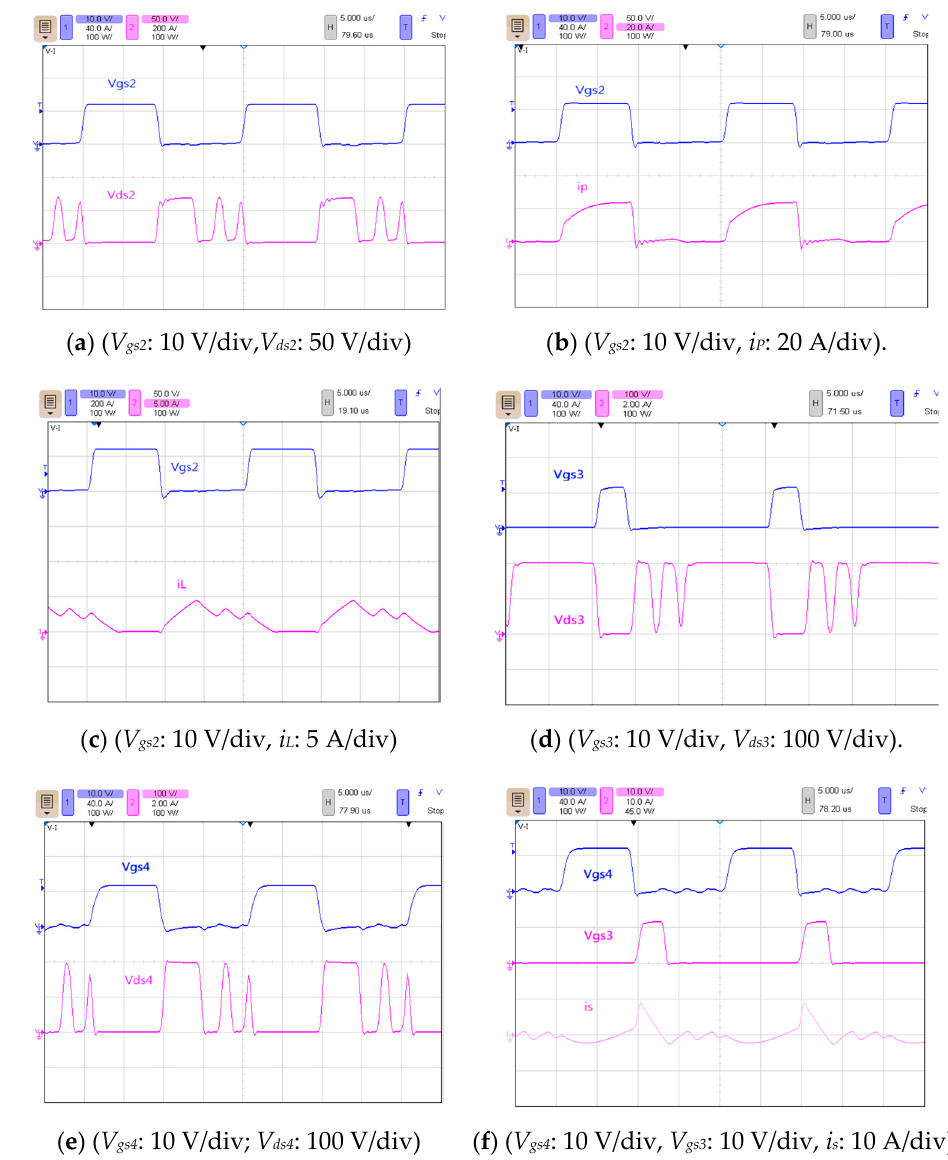
Figure 9. Measured waveforms under Stage 1 at half load: ( a ) switch S 2 waveform, ( b ) primary-side current waveform of transformer, ( c ) charging inductor current waveform, ( d ) switch S 3 waveform, ( e ) switch S 4 waveform, and ( f ) secondary-side current waveform of transformer.